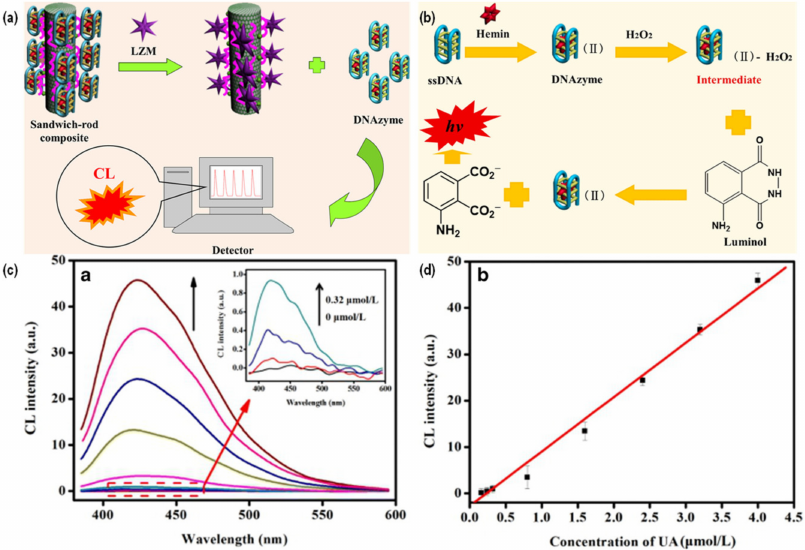
Figure 10. GQD nanocomposites as CL-based biosensors. Schematic illustration of ( a ) DNAzyme/L-Apt/GQDs@GO@CF for CL-based detection of LZM and ( b ) the corresponding CL mechanism [108]. ( c ) CL spectra of Cu(II)/Cu 2 O/NGQDs nanocomposites in the presence of different concentrations of UA, including 0 (black), 0.16 (red), 0.24 (blue), 0.32 (dark cyan), 0.8 (magenta), 1.6 (dark yellow), 2.4 (navy), 3.2 (pink), and 4.0 µ M (wine), and ( d ) the corresponding linear plot of the CL intensity at 422 nm with respect to UA concentration